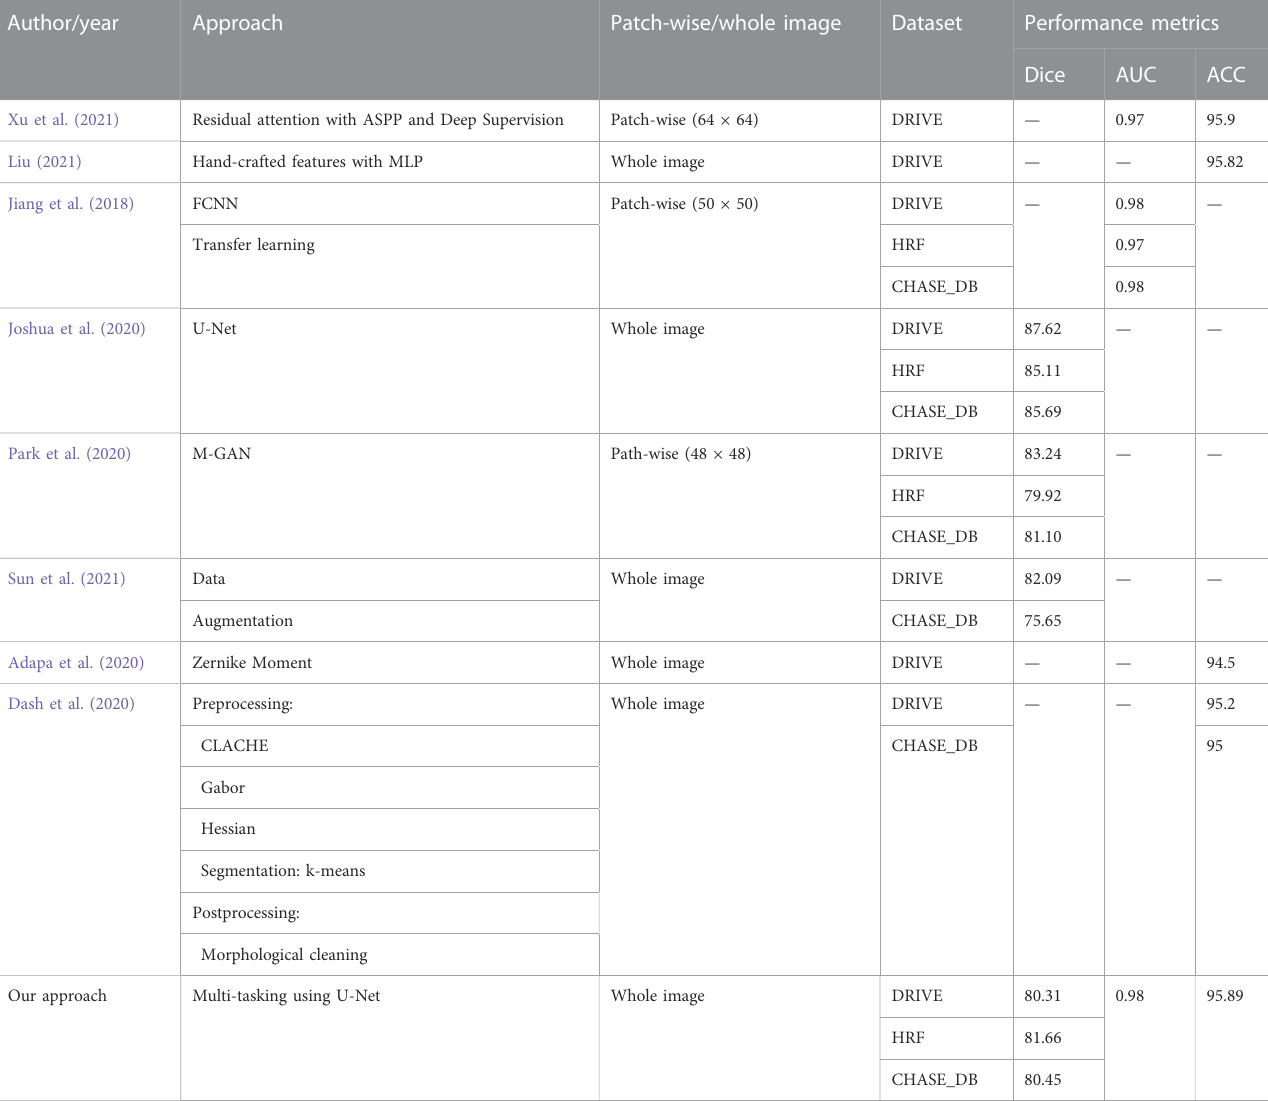
TABLE 4 Comparison of BV segmentation results of our approach with other up-to-date